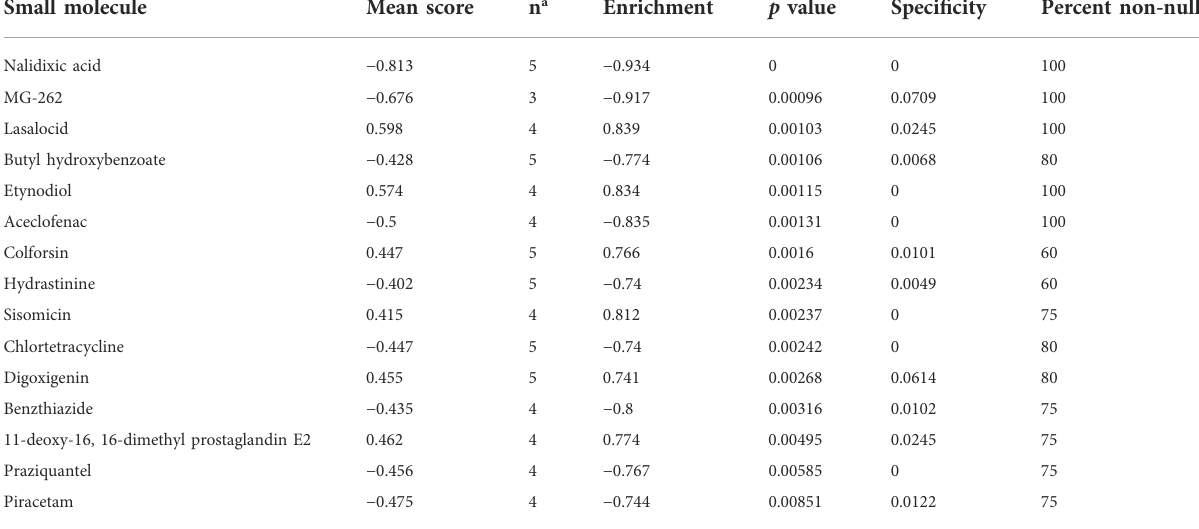
TABLE 2 Results of CMap